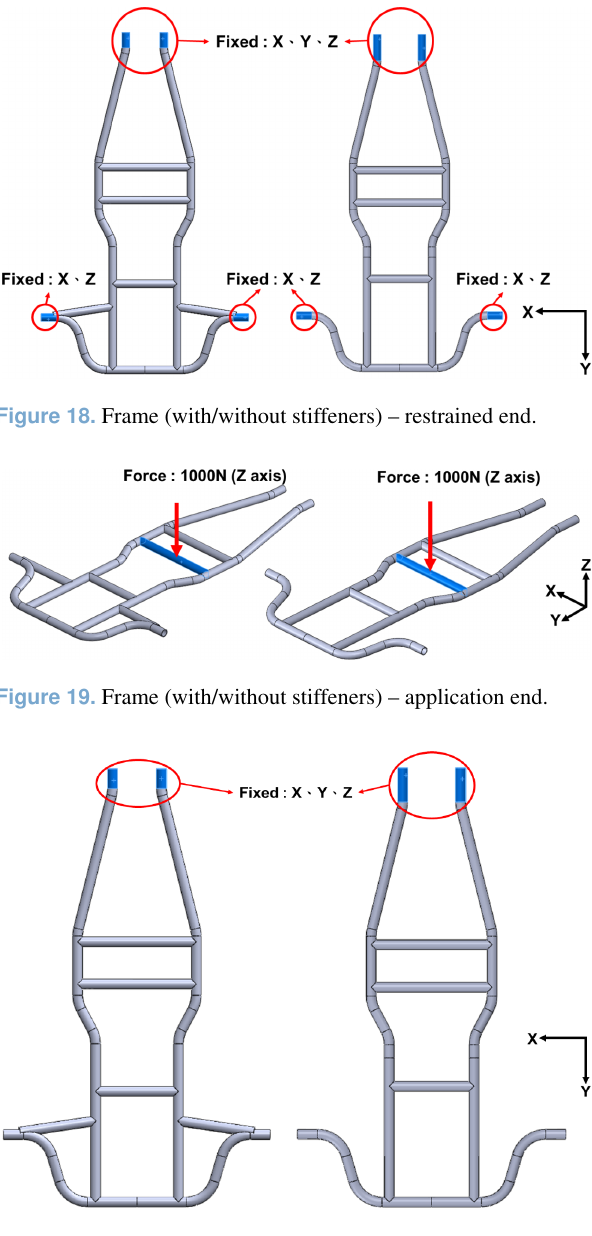
Figure 20. Frame (with/without stiffeners) – restrained